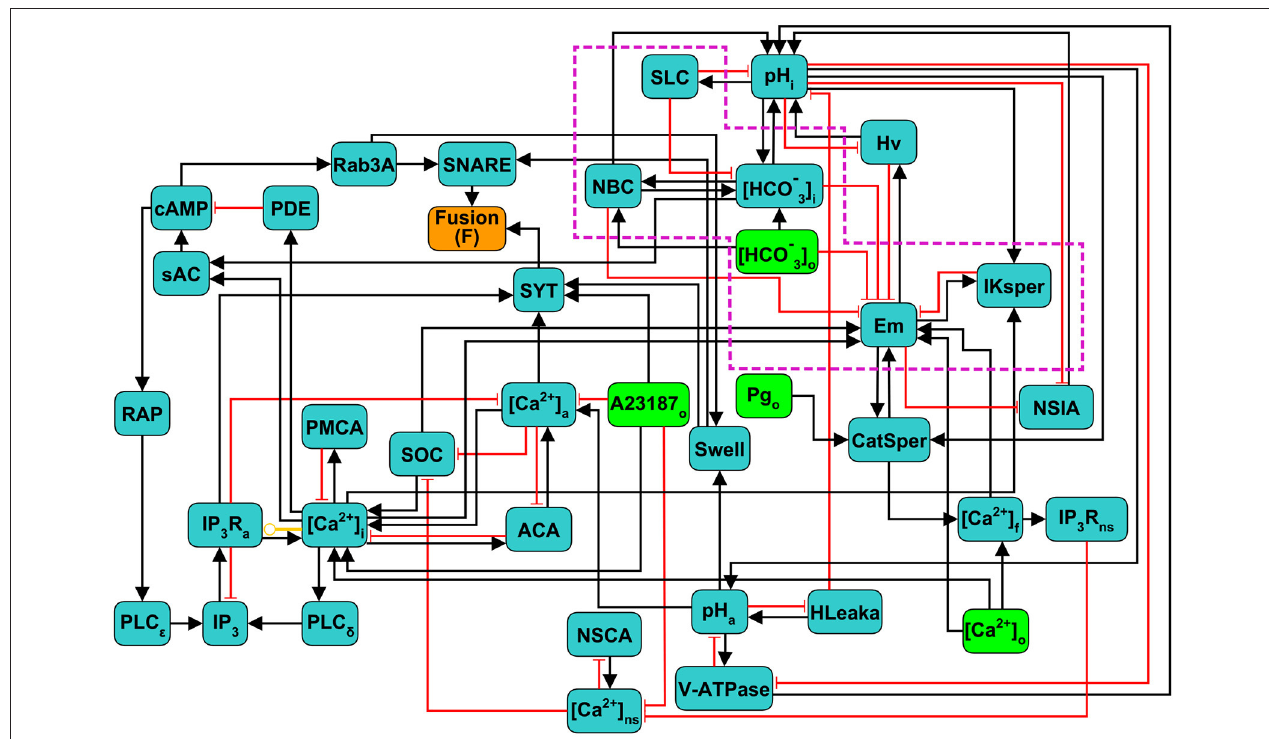
FIGURE 2 | Scheme of the discrete regulatory network for acrosome reaction (AR) in human sperm. Light green nodes indicate extracellular components that can be considered as external stimuli or inputs of the network, dark green nodes represent intracellular components, the orange node Fusion (F) is the network’s output reporter, representing the fusion between OAM and PM, that indicates AR completion. Black arrows indicate positive or activating interactions, red arrows indicate negative or inhibitory interactions, and yellow arrow indicates a dual interaction, depending on the values of the nodes involved. Subscripts indicate the physical location in the sperm of the physiological component represented by its corresponding node: i,a,o,f and ns represent intracellular, acrosomal, outer (extracellular medium), flagellar and neck store, respectively. Nodes inside the purple doted box are mostly involved in capacitation and are included as control variables of the necessary conditions to undergo